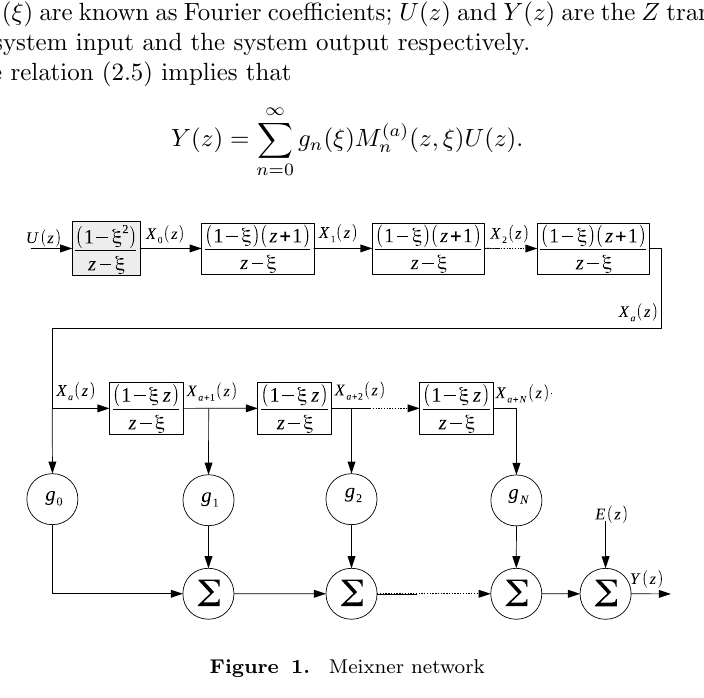
Figure 1. Meixner